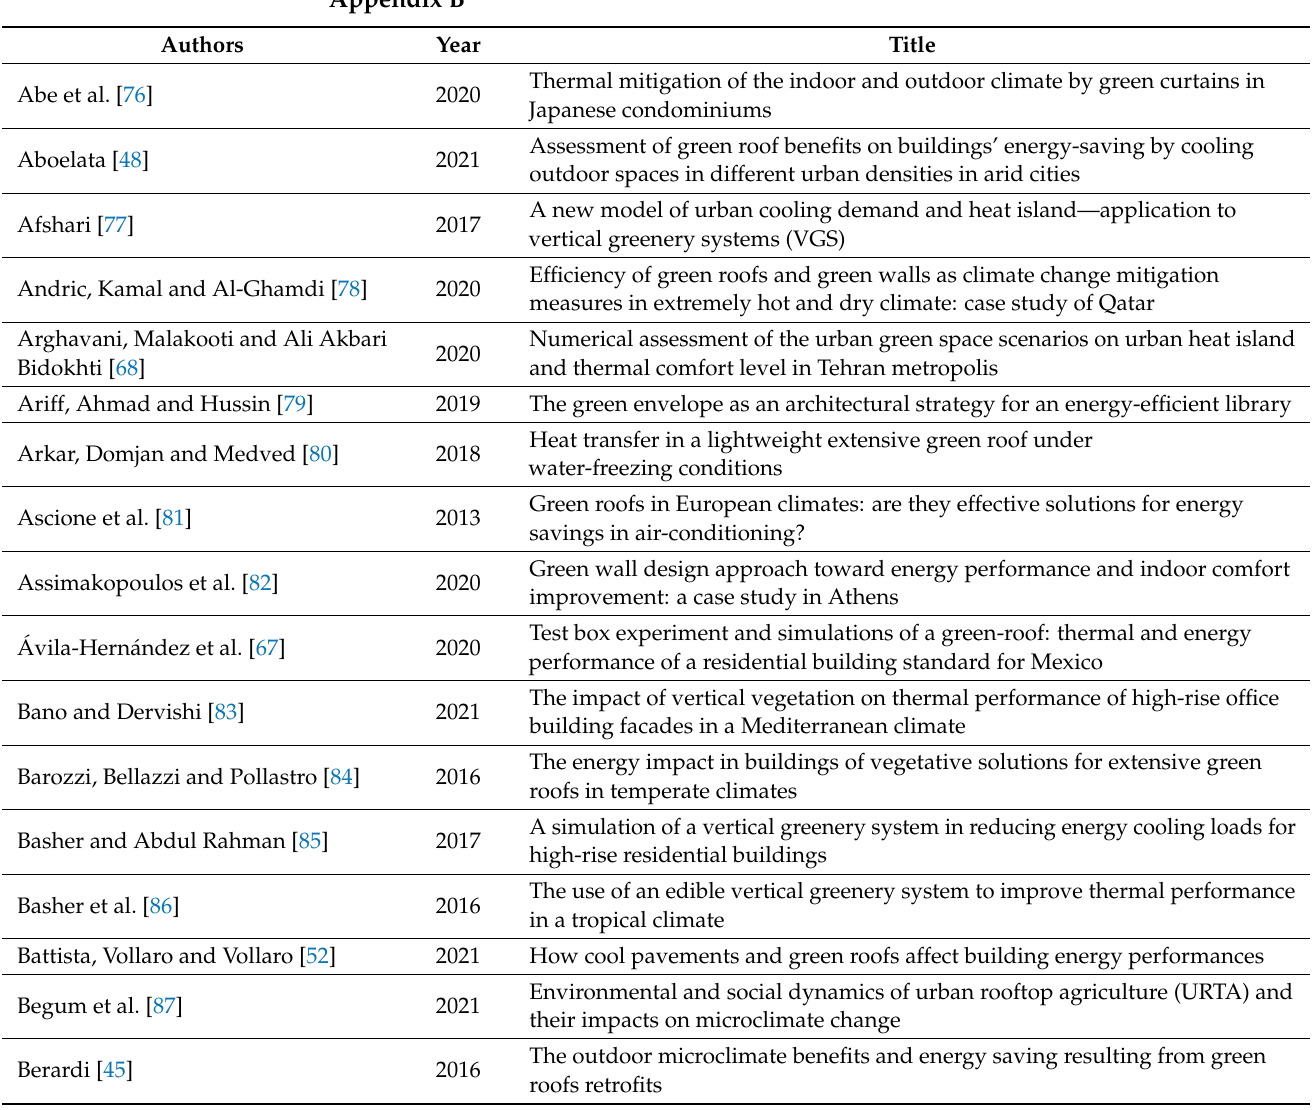
Codes used for the SCOPUS search engine TITLE-ABS-KEY(“green roof*” OR “green rooftop*” OR “wetland roof*” OR “roof garden*” OR “rooftop garden*” OR “vertical greenery systems” OR “green wall*” OR “living wall*” OR “green façade*” OR “vegetation screen*” OR “green curtain*” OR “vegetation curtain*” OR “urban garden*” OR “community garden*” OR “garden farm*” OR “garden bed*” OR “planter box*” OR “urban farm*” OR “urban farming” OR “urban agricultures” OR “hydroponics*” OR “aquaponics*”) AND TITLE-ABS-KEY(“thermal comfort” OR “thermal stress” OR “thermal performance” OR “urban heat” OR “heat island” OR “cooling effect” OR “surface temperature” OR “air temperature”) AND TITLE-ABS-KEY (“energy consumption” OR “energy saving” OR “energy demand” OR “energy balance” OR “energy efficiency” OR “energy usage” OR “electricity” OR